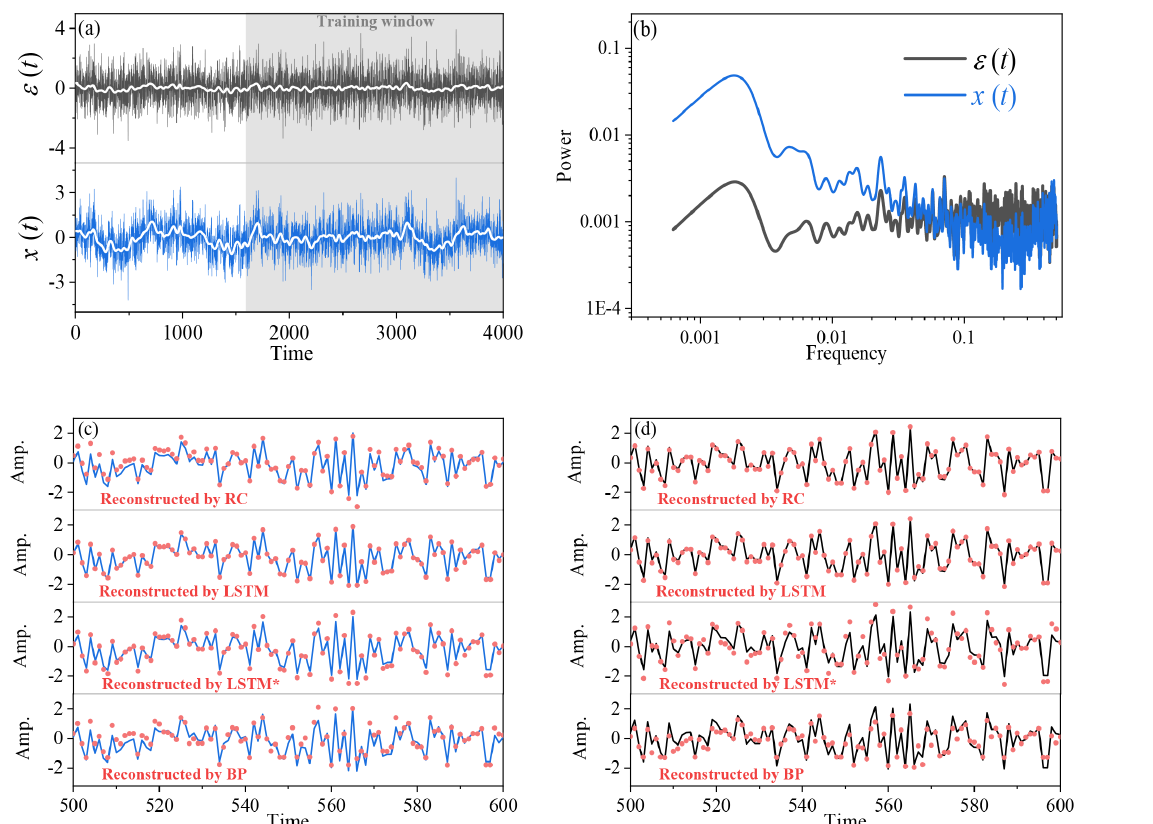
Figure 4. (a) The x ( t ) time series (blue) and the ε ( t ) time series (black) of the ARFIMA (3,0.2,3) model. White lines denote the results of a 50-step running average. (b) Comparison of power spectra between x ( t ) and ε ( t ). (c) Comparison of the reconstructed time series of x ( t ) by RC, LSTM, LSTM ∗ , and BP (red dots), and blue lines denote the real x ( t ). (d) Comparison of the reconstructed time series of ε ( t ) through RC, LSTM, LSTM ∗ , and BP (red dots), and black lines denote the real ε ( t ).